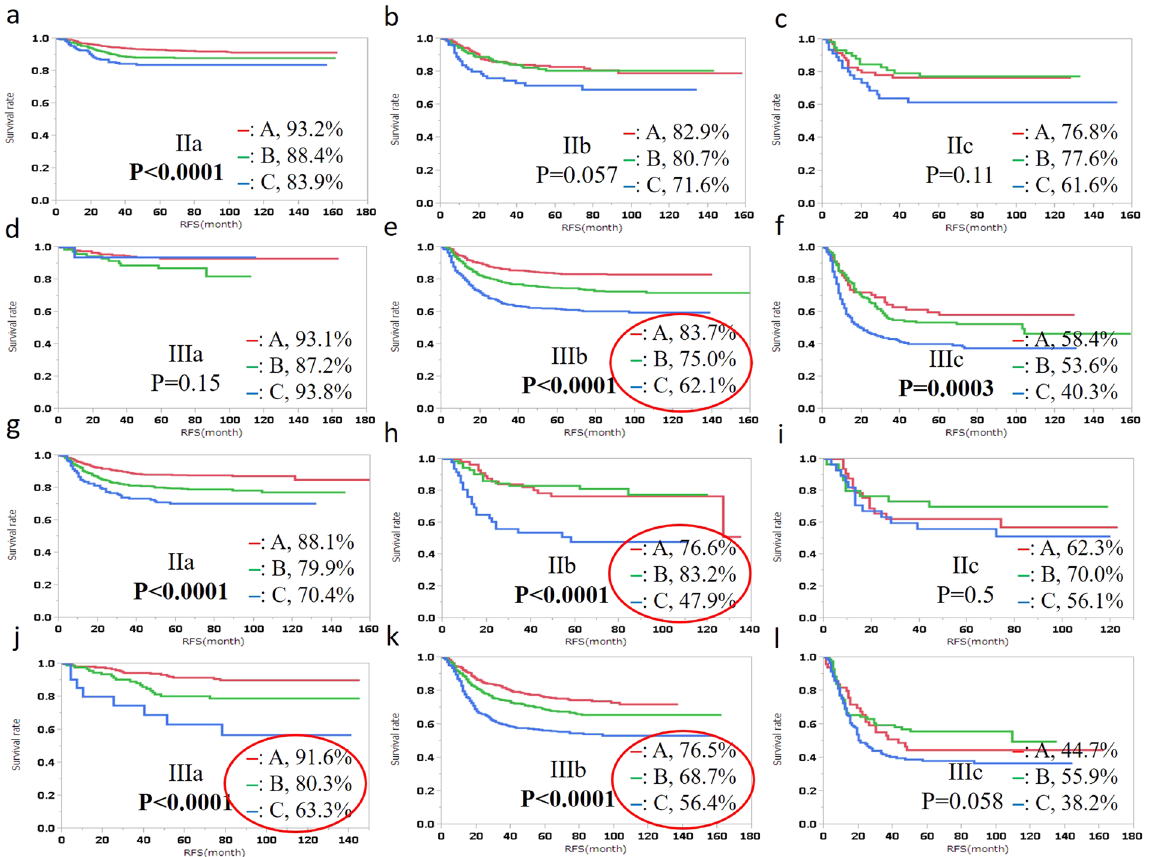
Figure 1. Relapse-free survival (RFS) of colon cancer ( a – f ) and rectal cancer patients ( g - l ) by TM-LVI status is shown for each TNM stage. The 5-year RFS rate is described on the right of the TM-LVI status. Bold type, P < 0.05; Red circle, difference in the RFS rate among TM-LVI statuses >